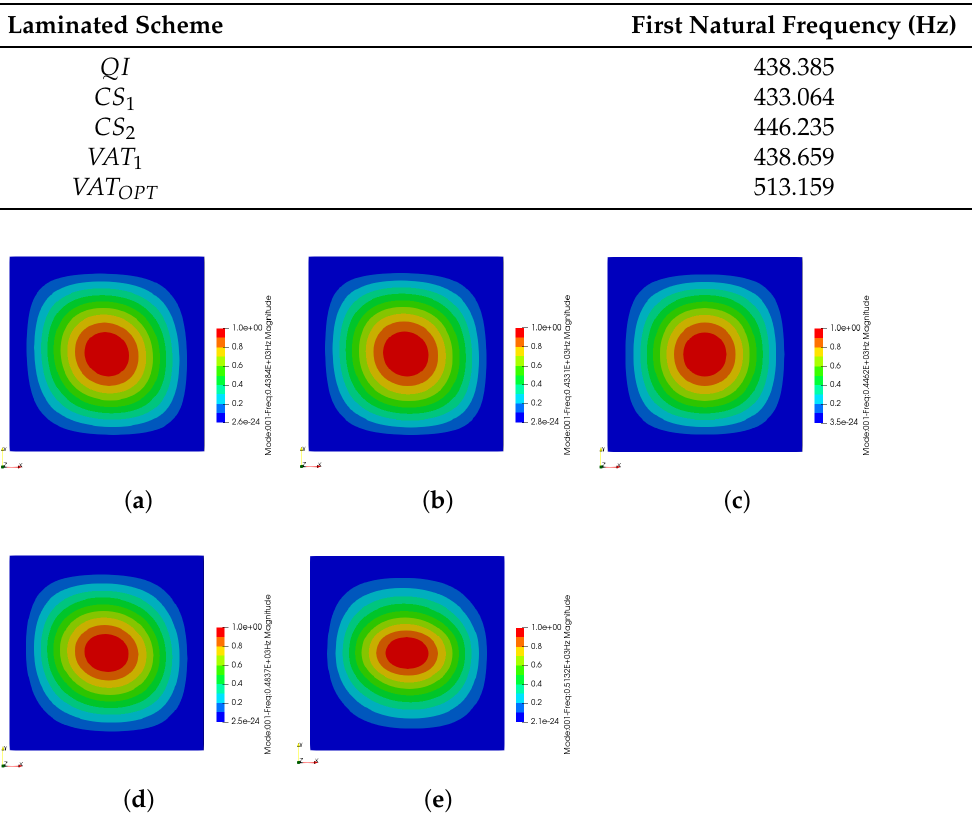
Figure 13. First natural frequency modes in various layup designs. ( a ) QI. ( b ) CS1. ( c ) CS2. ( d ) VAT 1 . ( e ) VAT OPT